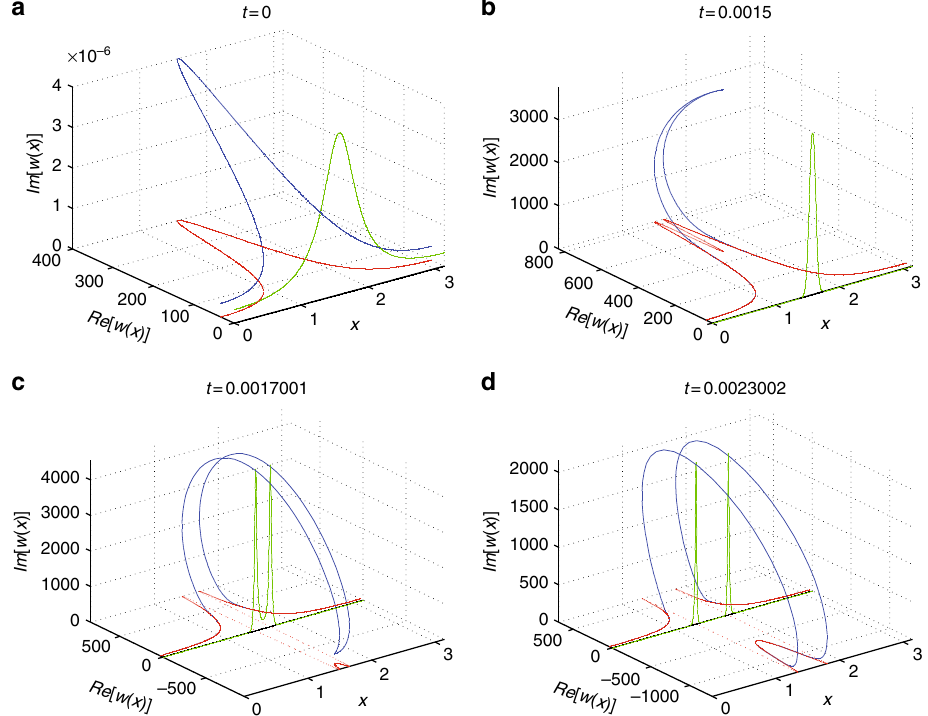
Fig. 5 Simulation of the complexi fi ed form of the PDE model. The solution of the complex equation associated with the real and imaginary parts of Eqs. (28), (29) at various time instances a t = 0, just before the collapse time b , where the complex solution starts going back on itself rather than collapse (as it would for purely real initial data); c , d snapshots of the solution re-emerging on the other side (the negative real axis end of the complex plane). Notice the visual similarity with the images in Fig.